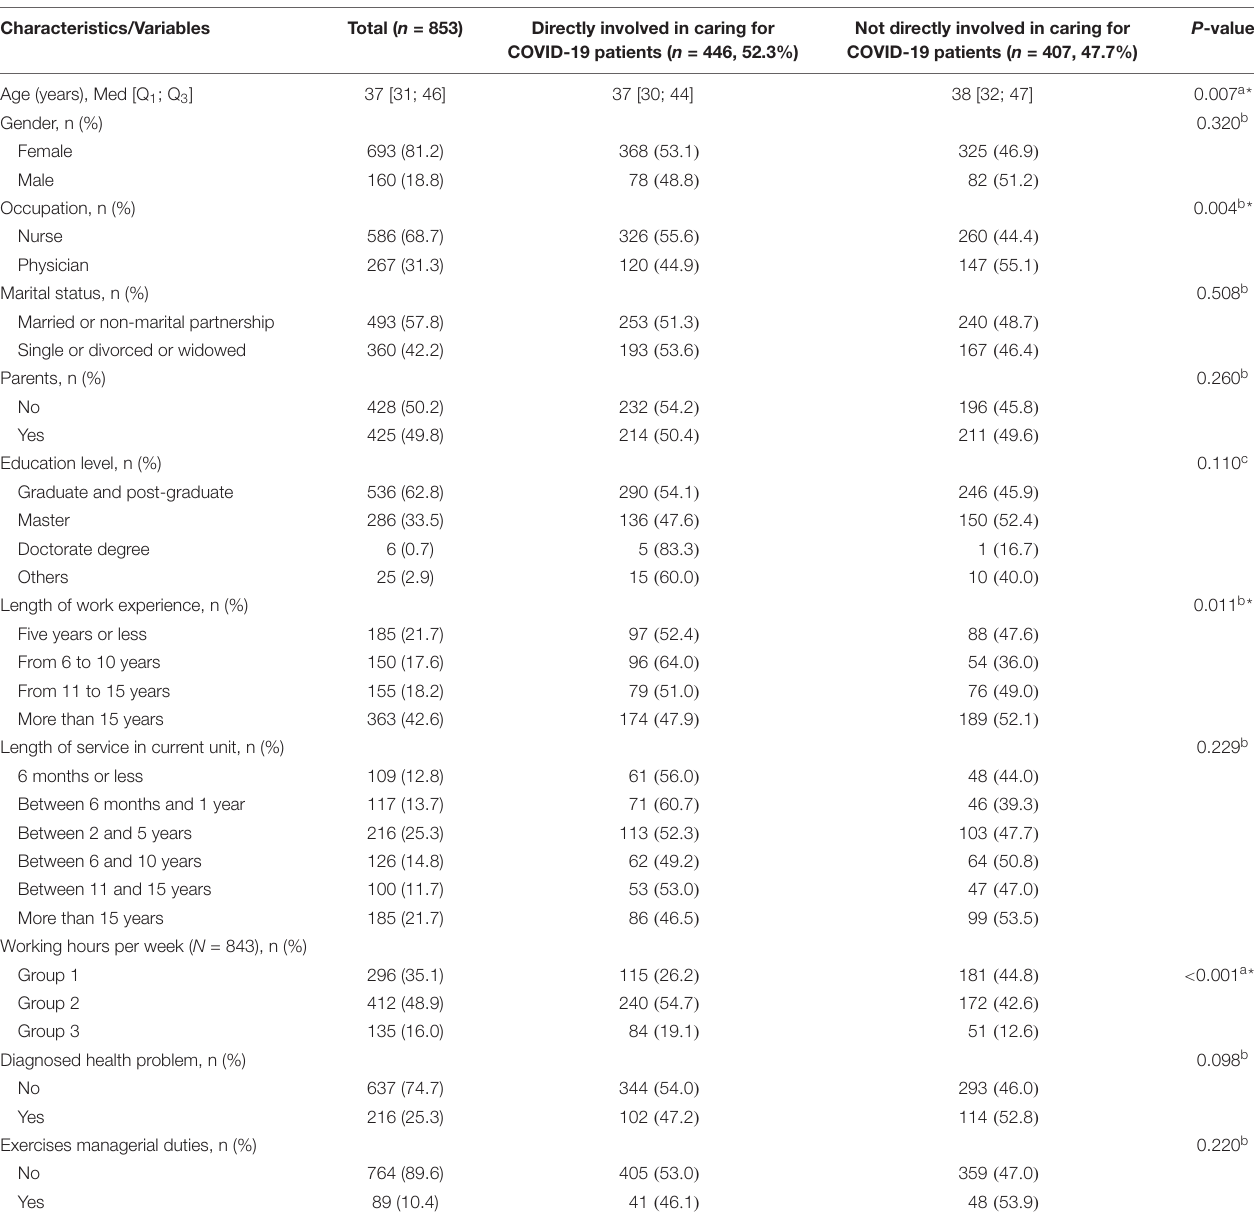
TABLE 1 | Demographic and professional characteristics ( n = 853).